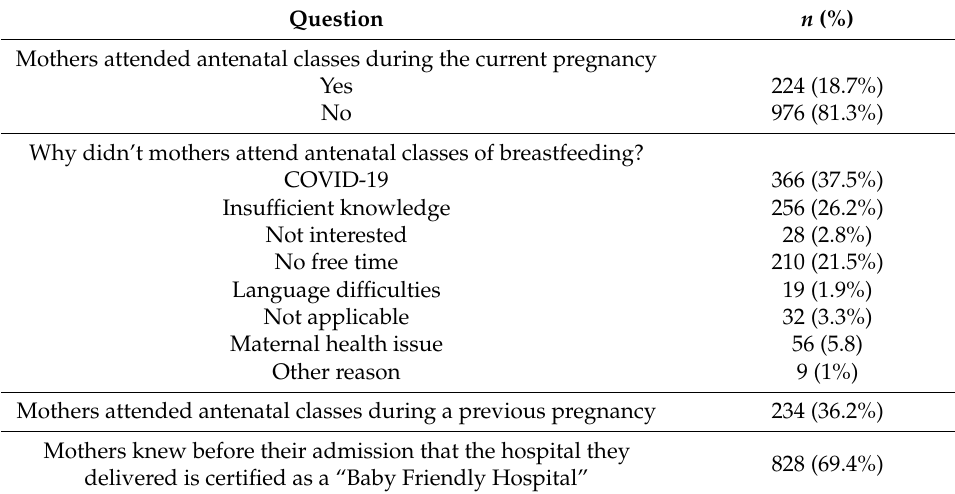
Table 2. Characteristics about the antenatal courses of